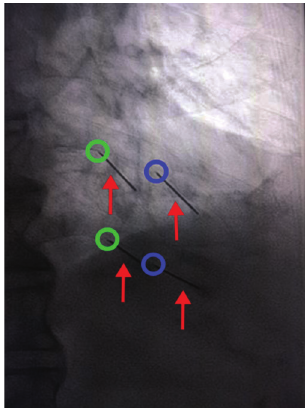
Figure 1 - The setup of the Single-point group. The red arrows refer to the puncture needles. The blue circles are shown as the lesion point.